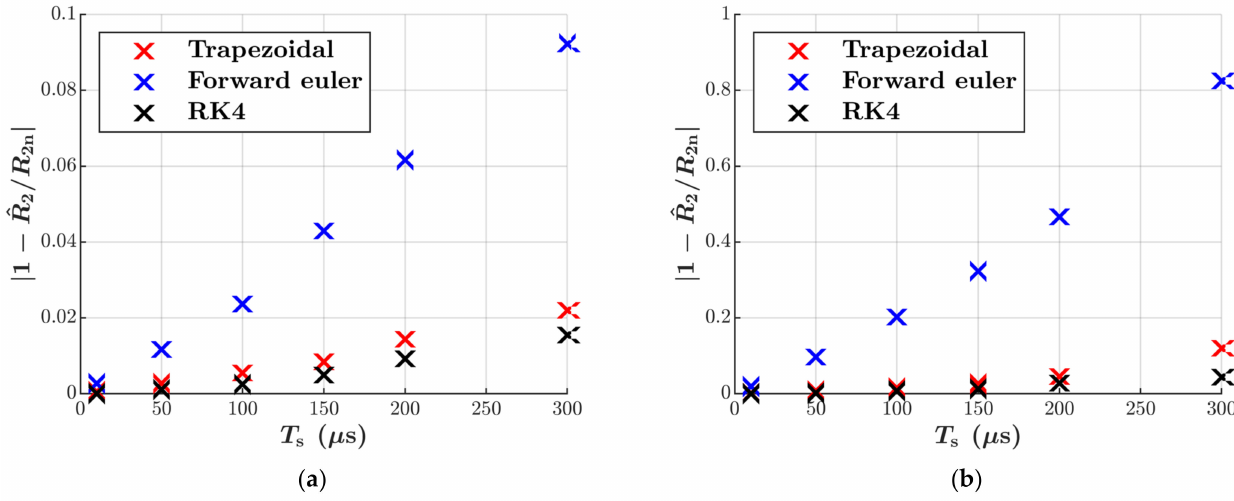
Figure 12. The effect of discretization and sampling time T s on Q-MRAS accuracy at different operating points. ( a ) 20% of the nominal speed and 50% of the nominal torque; ( b ) 80% of the nominal speed and 50% of the nominal